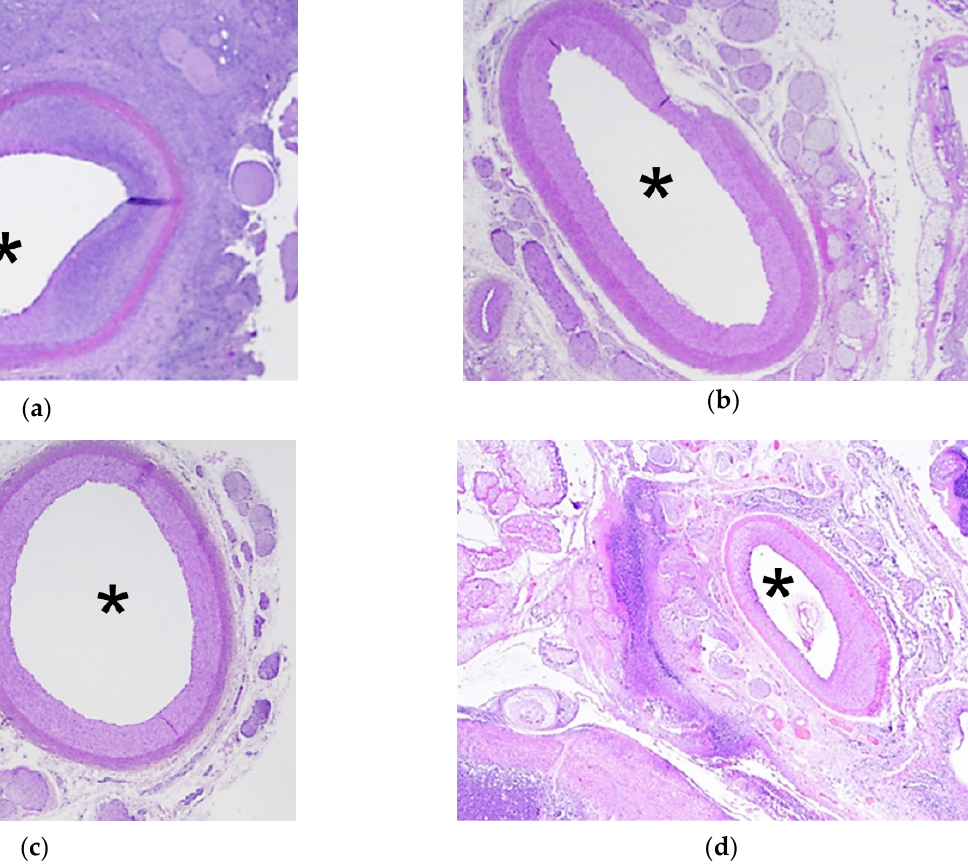
Figure 6. Histological examination of the treated arteries (location indicated by *) for group 1–4 ( a – d ). Hematoxylin and eosin stain; magnification ×100.